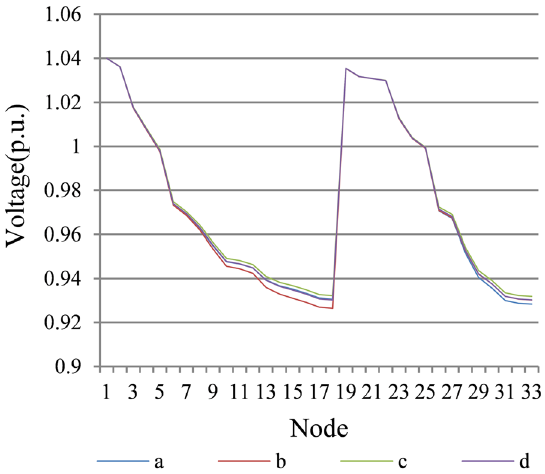
Fig. 10 Voltage profile of different DESS with different